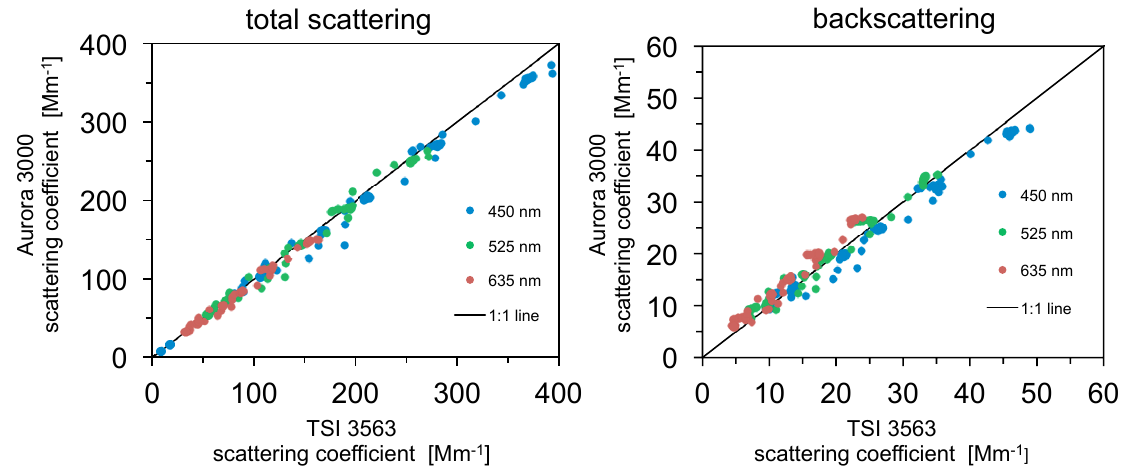
Fig. 6. Results from experiments with ammonium sulphate. Correlation between total scattering coefficients measured with the TSI 3563 and Aurora 3000, respectively. The left panel shows the correlation for total scattering coefficients including truncation correction. Wavelengths for TSI 3563 were adjusted to 450, 525, and 635nm. The right panel is similar to the left panel but for backscattering coefficients.